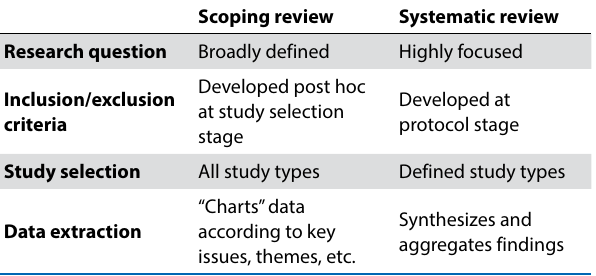
Table 1: Differences between scoping and systematic